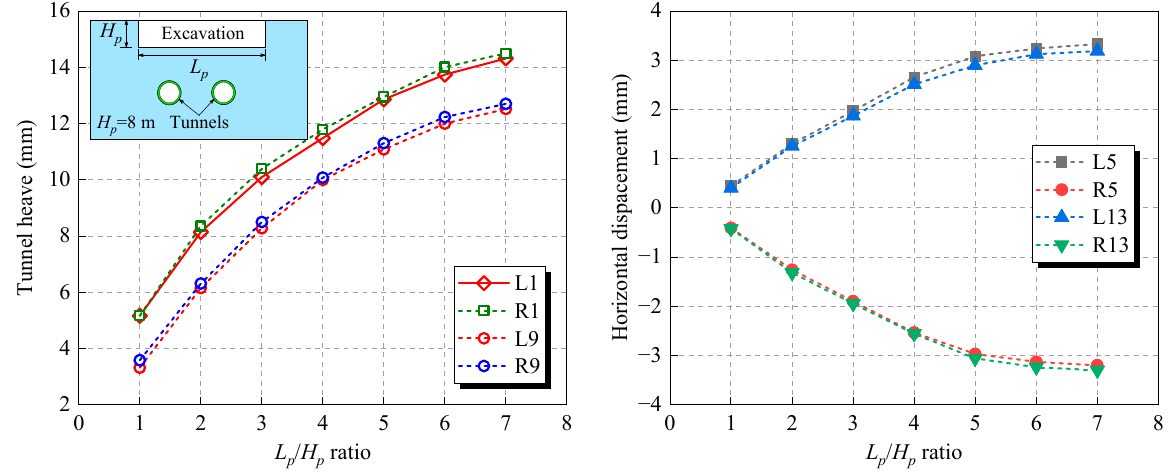
Figure 17. Influence of L p / H p ratio on tunnel displacement.